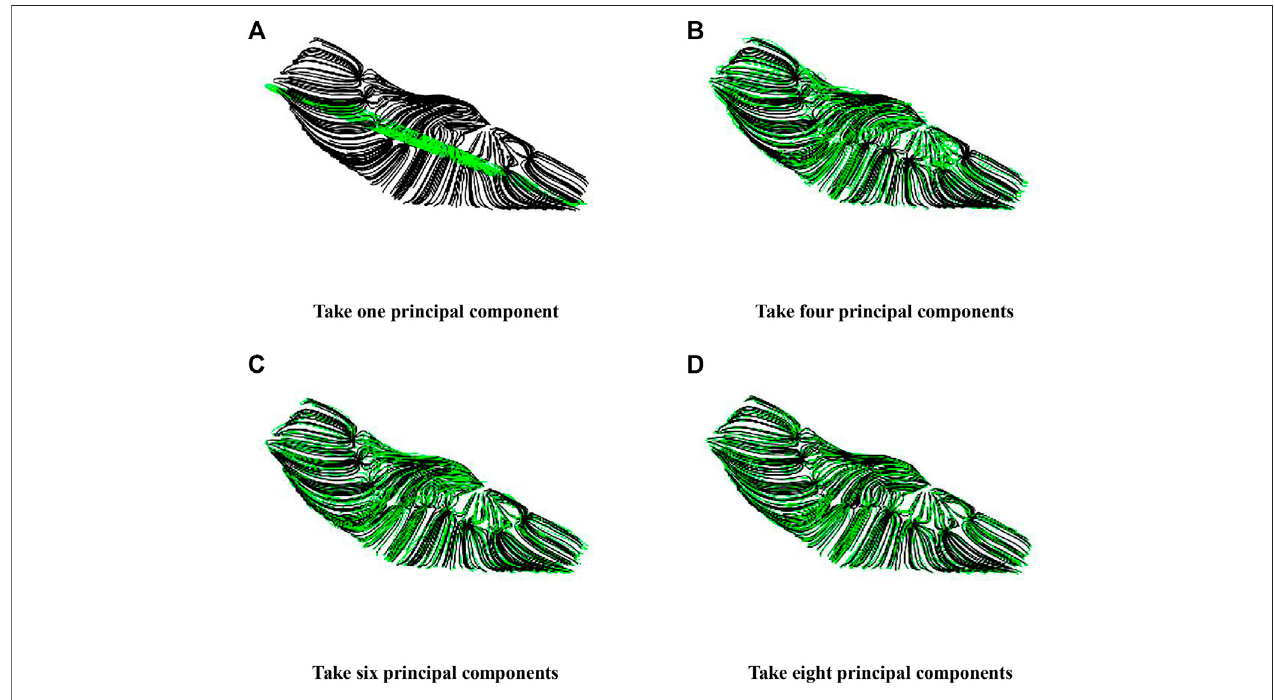
FIGURE 3 | Principal component selection and fl ow fi eld reconstruction